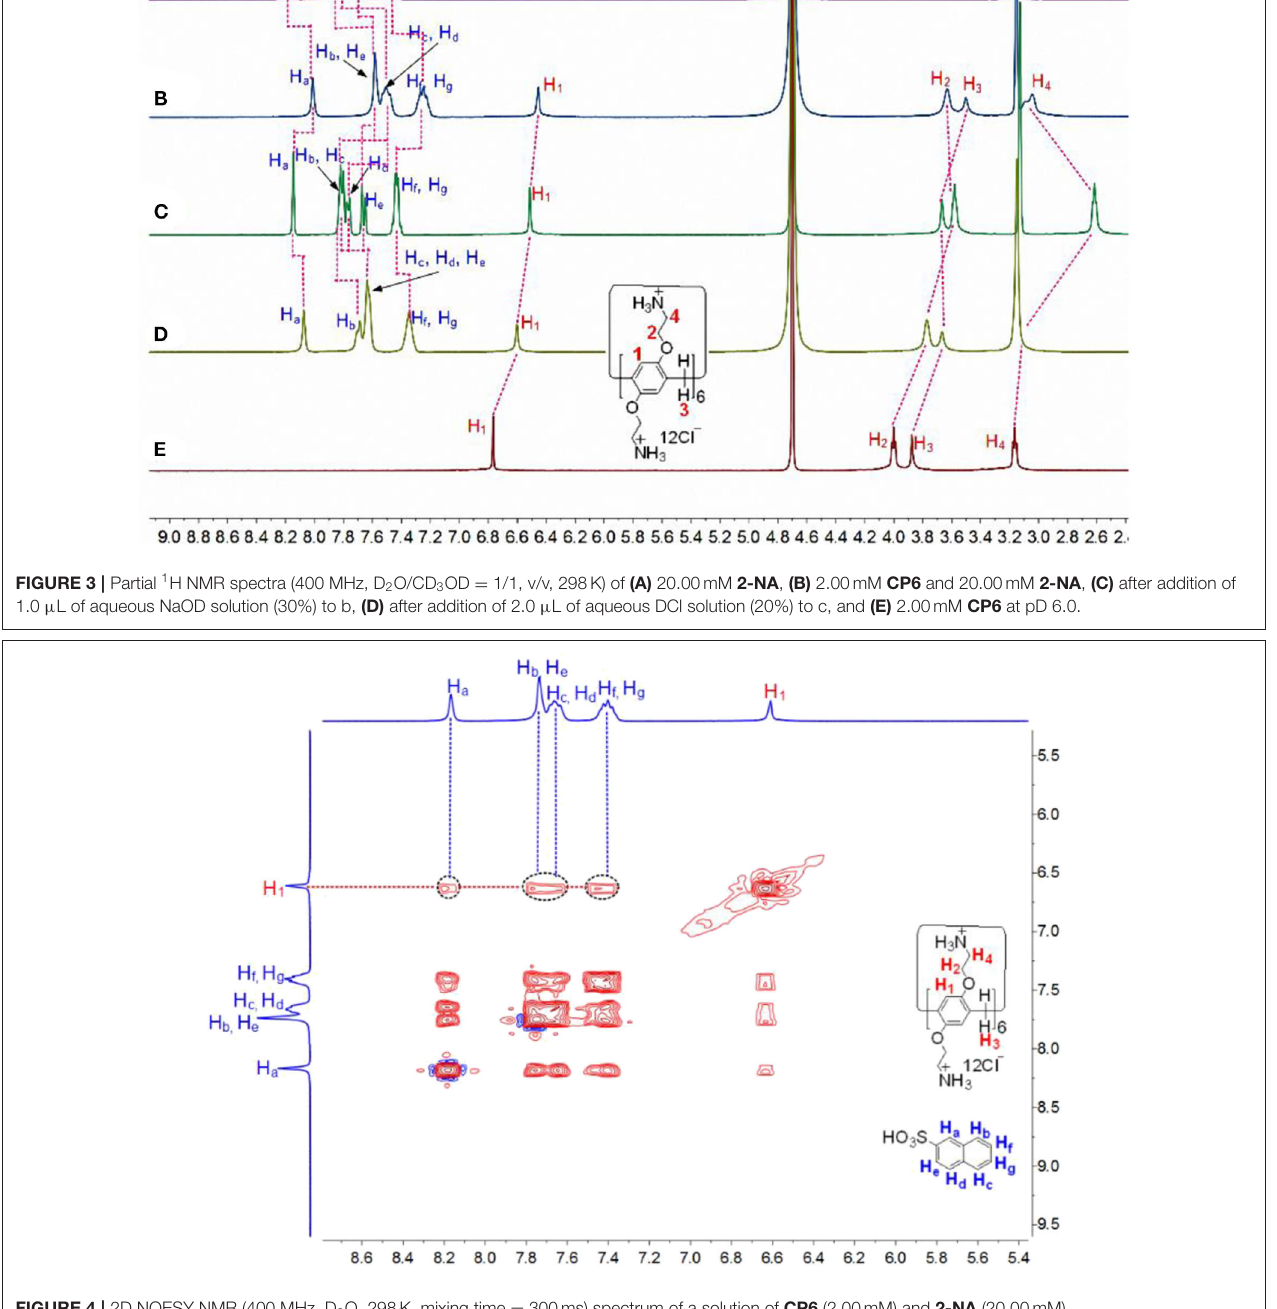
FIGURE 4 | 2D NOESY NMR (400 MHz, D 2 O, 298K, mixing time = 300ms) spectrum of a solution of CP6 (2.00mM) and 2-NA (20.00mM). π - π stacking interaction with the host cavity (Gómez et